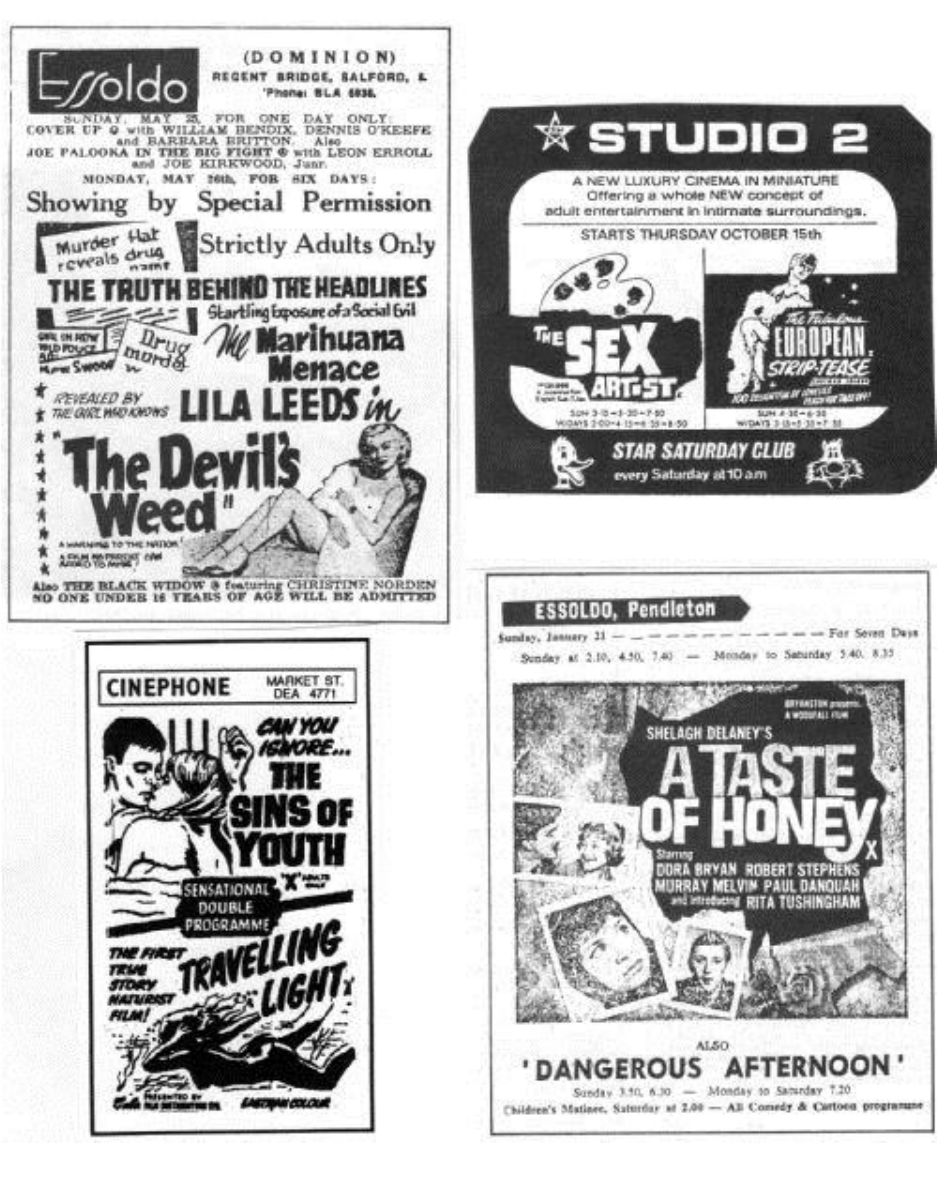
Figure 1 - Examples of cinema advertising of ‘X’ and uncertificated films in the Manchester area during the 1950s and 1960s (courtesy of Manchester Libraries, Information and Archives, Manchester City